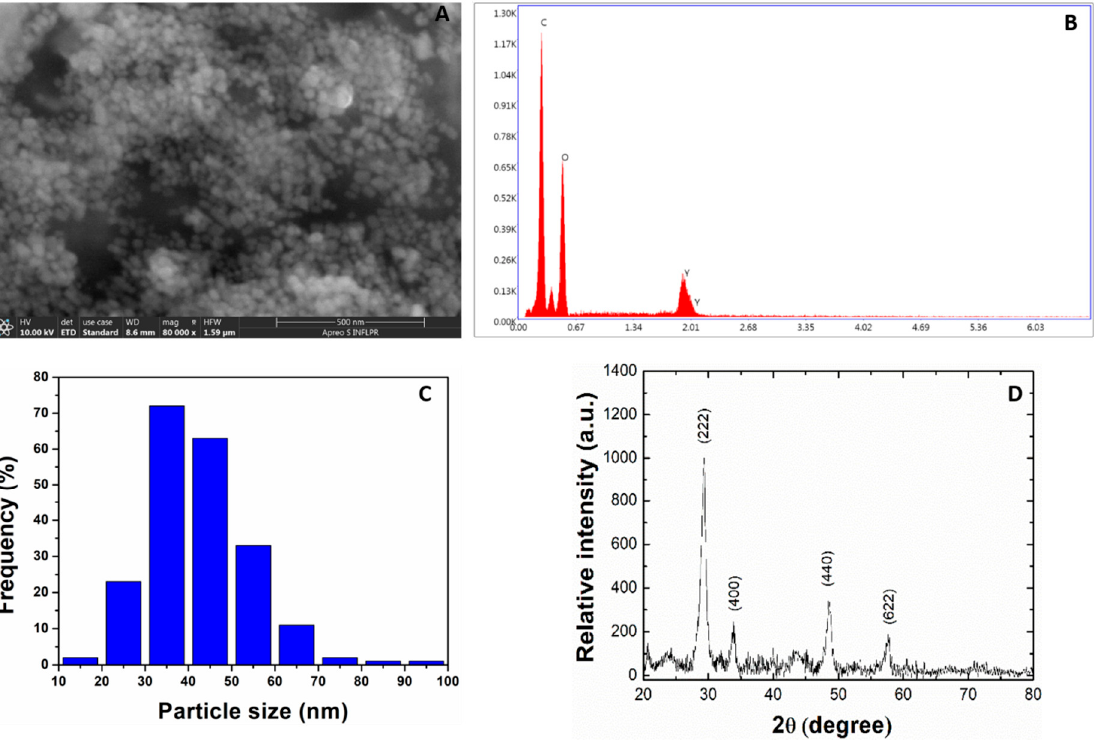
Figure 1. Y 2 O 3 NPs characterization by ( A ) SEM analysis and corresponding ( B ) EDX pattern, ( C ) NPs size distribution from SEM images and ( D ) X-ray diffractograms.